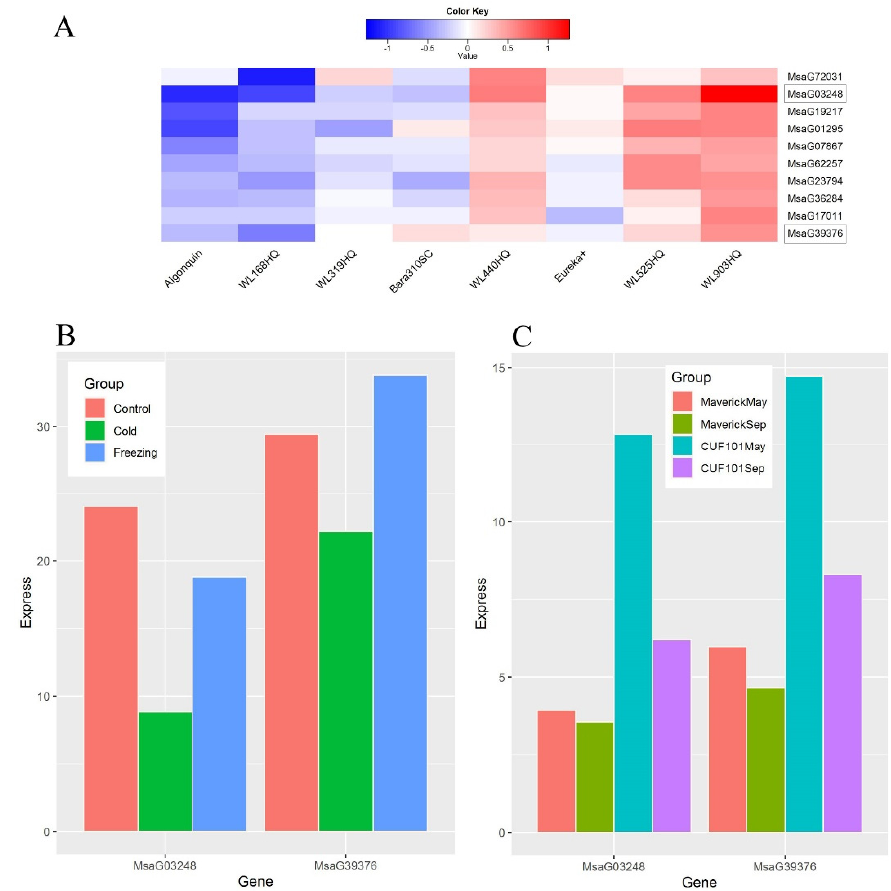
Figure 7. Alfalfa FIB genes expression in response to cold and/or fall dormancy process. Note: ( A ). The expression profiles of alfalfa genes involving in ribosome biogenesis process under cold stress. The FIB genes were marked with rectangle frame, and the RNA-seq data were collected in present research. ( B ). The expression profiles of two alfalfa FIB genes in response to cold and freezing stress, and the RNA-seq data were collected from our previous research [20]. ( C ). The expression profiles of two FIB genes in two cultivars during the fall dormancy process and the RNA-seq data were collected from the research by Zhang et al. [29].